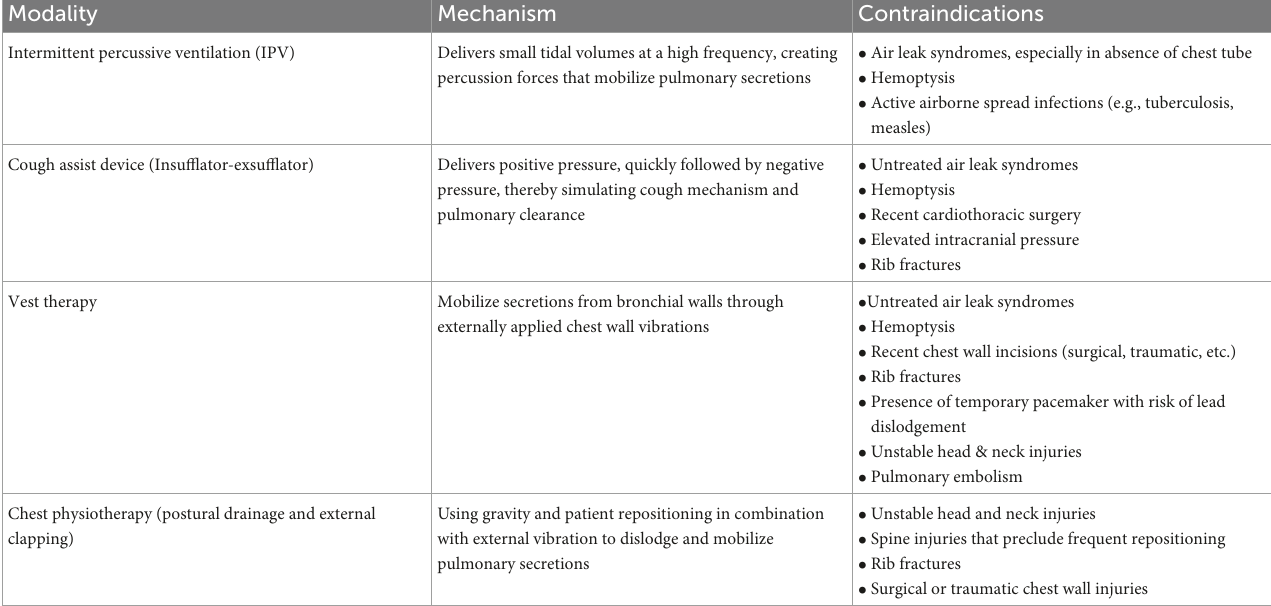
TABLE 1 Summary of airway clearance modalities, with mechanisms of action, and contraindications.